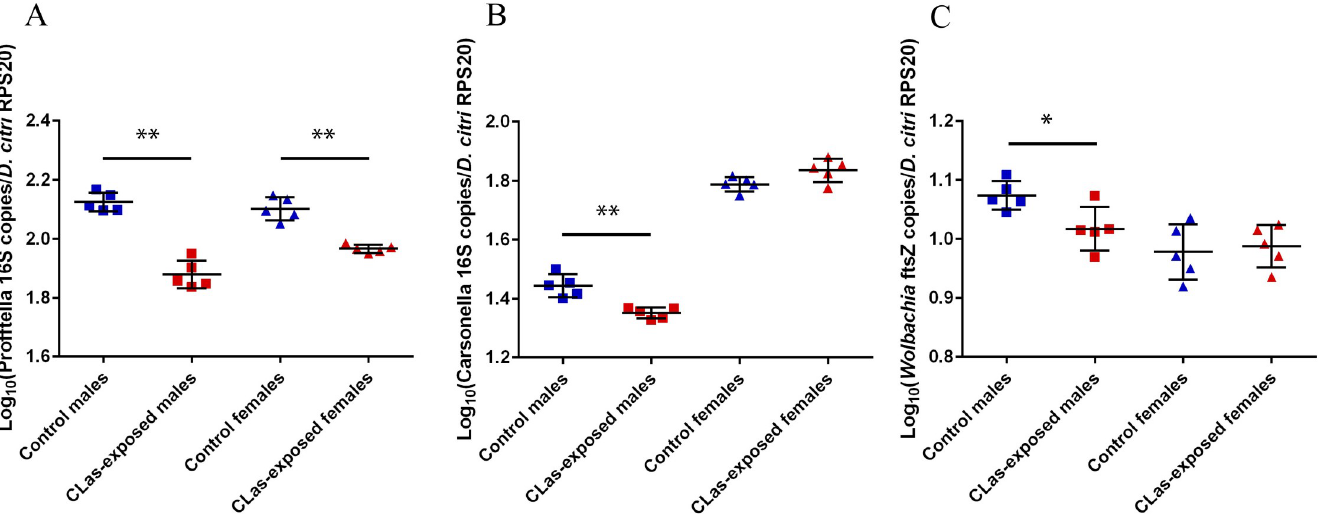
Fig 4. Endosymbiont densities in D . citri . The density of Profftella (A), Carsonella (B), and Wolbachia (C) in adult D . citri was measured by copies of Profftella 16S rRNA gene, Carsonella 16S rRNA gene, and Wolbachia filamentation temperature-sensitive protein Z gene ( ftsZ ), respectively, per D . citri ribosomal protein S20 gene. Mean log 10 -transformed density of each bacterium in control and CLas-exposed males (blue and red squares, respectively), and in control and CLas-exposed females (blue and red triangles, respectively) was compared using unpaired, two-tailed t-test, with FDR of 5%.